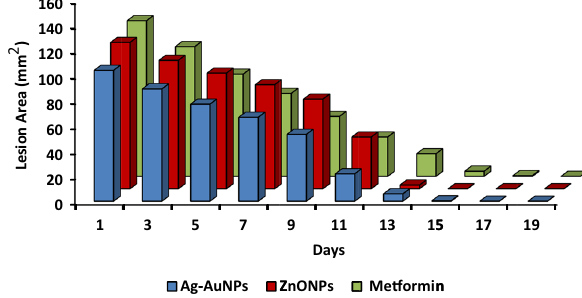
Figure 7: Wound closure rate ( lesion area in mm 2 ) in animals after lesioning and treatment with metformin ( MT ) , gold – silver nano - composite ( CNPs ) , and zinc oxide nanoparticles ( ZnONPs ) .